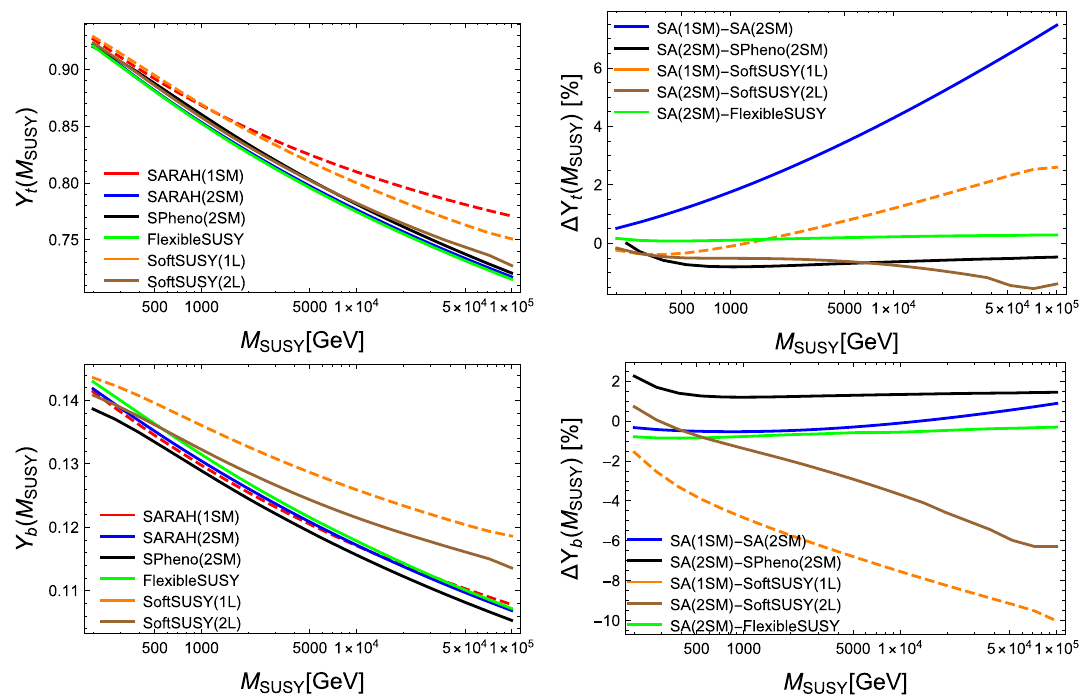
Fig. 2 The DR values of the running top and bottom Yukawa cou- plings at the SUSY scale. The dashed red line shows the result using the one-scale matching as done by earlier SARAH / SPheno version, while the blue line is the new results from SARAH and black the one from SPheno . In addition, we show the results for SoftSUSY using